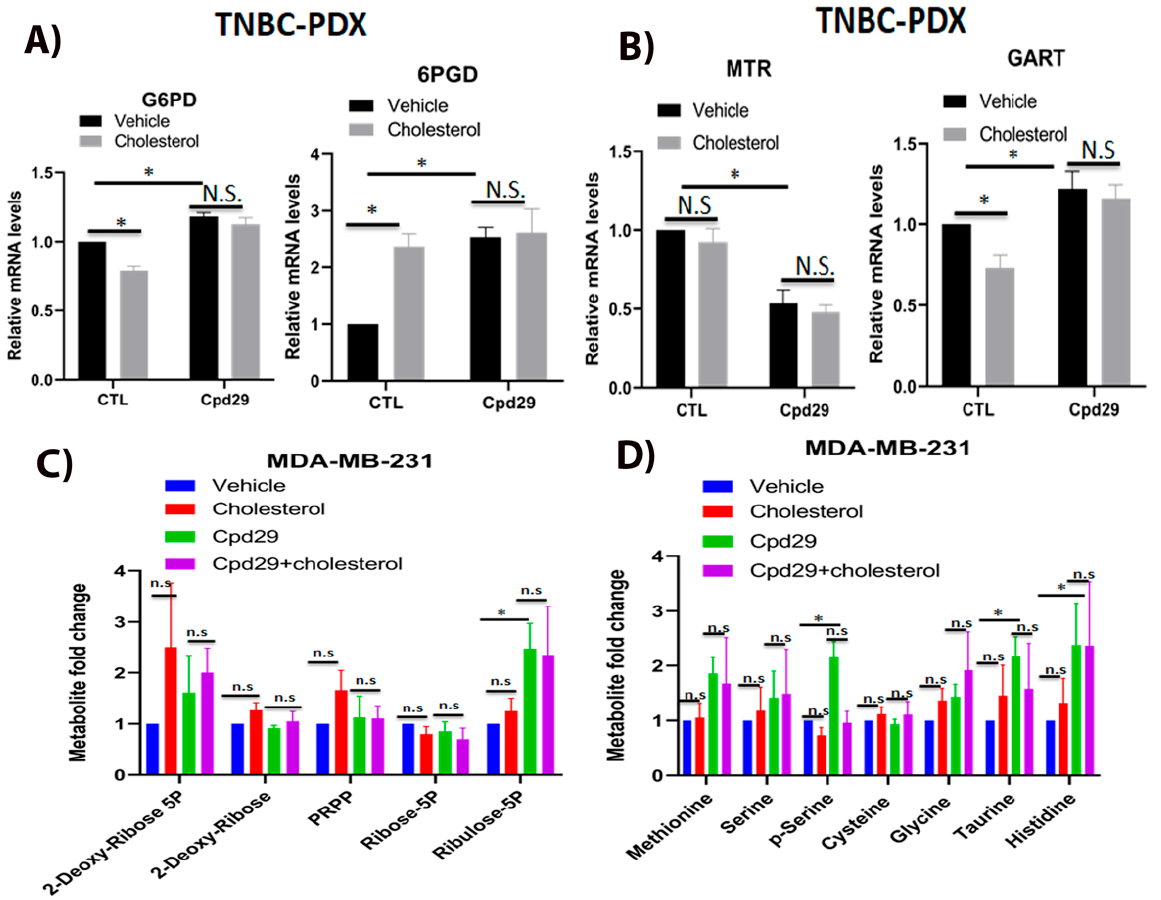
Figure 5. Cholesterol does not alter the metabolite levels involved in PPP and OCM pathways in TNBC cells. ( A ) TNBC-PDX cells were treated with vehicle (Veh), cholesterol (Chol, 10 μ M), and/or cpd29 (10 μ M) for 48 h. Total RNA was extracted and analyzed using RT-qPCR. The genes involved in PPP included: G6PD: glucose-6-phosphate 1-dehydrogenase, 6PGD: 6-phosphogluconate dehydrogenase. ( B ) TNBC-PDX cells were treated with vehicle (Veh), cholesterol (Chol, 10 μ M), and/or cpd29 (10 μ M) for 48 h. Total RNA was extracted and analyzed using RT-qPCR. The genes involved in the OCM pathway included: MTR: 5-methyltetrahydrofolate-homocysteine methyltransferase, GART: trifunctional purine bi- osynthetic protein adenosine-3. The mRNA data were normalized to endogenous GAPDH. CTL (control) represents the breast cancer cells treated with cholesterol or vehicle. ( C ) The metabolic profiling on PPP intermediates was carried out using LC/MS. The data were normalized for cell count and the respective vehicle. MDA-MB-231 cells were treated with vehicle (Veh), cholesterol (Chol, 5 μ M), and/or cpd29 (5 μ M), for 48 h. ( D ) The metabolic profiling on OCM intermediates